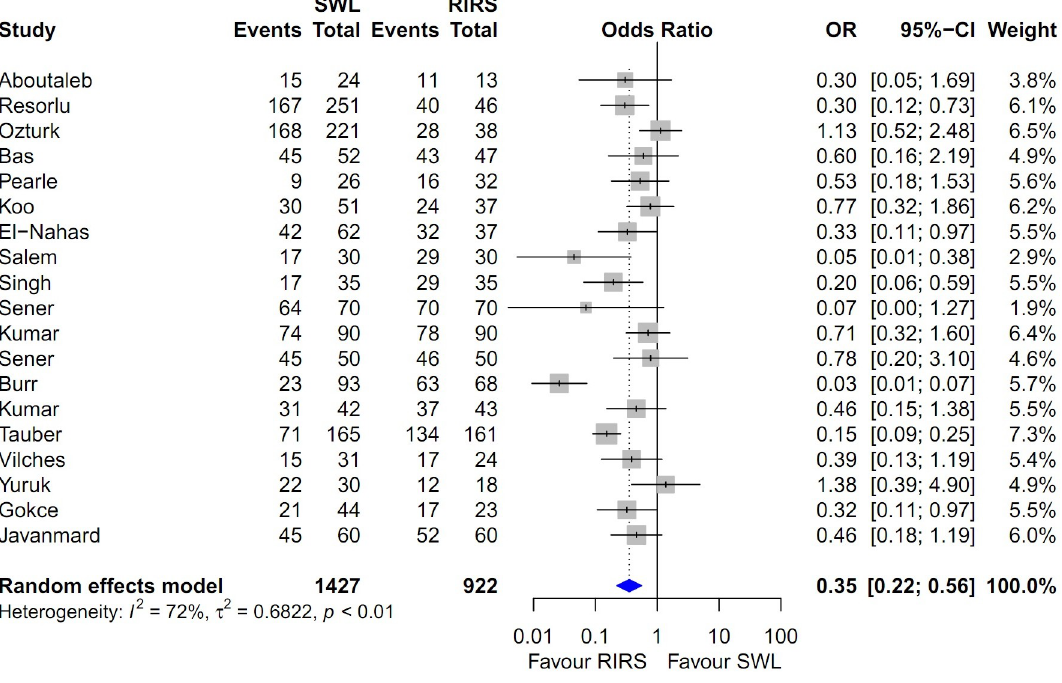
PLOS ONE | https://doi.org/10.1371/journal.pone.0211316 February 21,